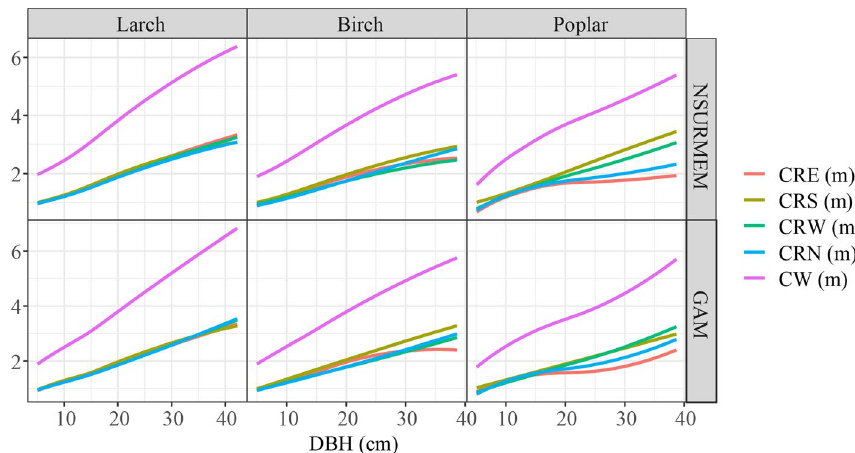
Fig. 6 Intraspecific and interspecific variability in CR and CW for the three species generated using NSURMEM and GAM systems